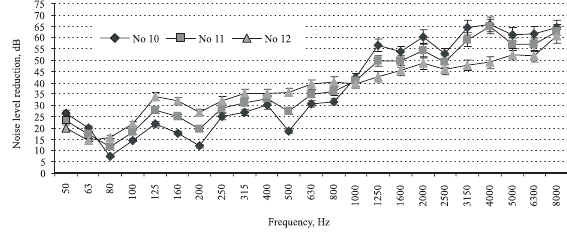
Fig. 5. Impact of No 10, No 11 and No 12 samples of experi- mental structures (Table 1) on noise suppression efficiency